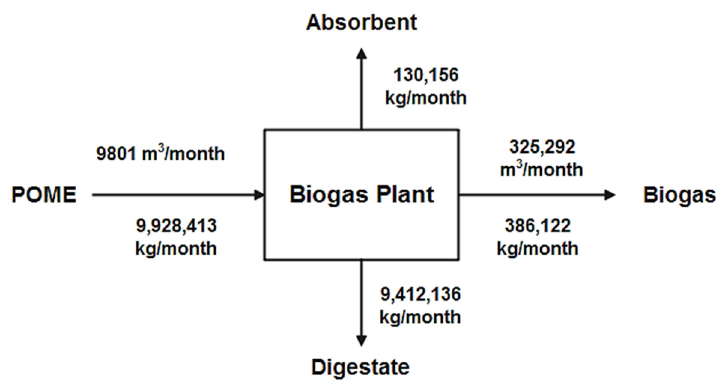
Figure 4. The total mass balance.